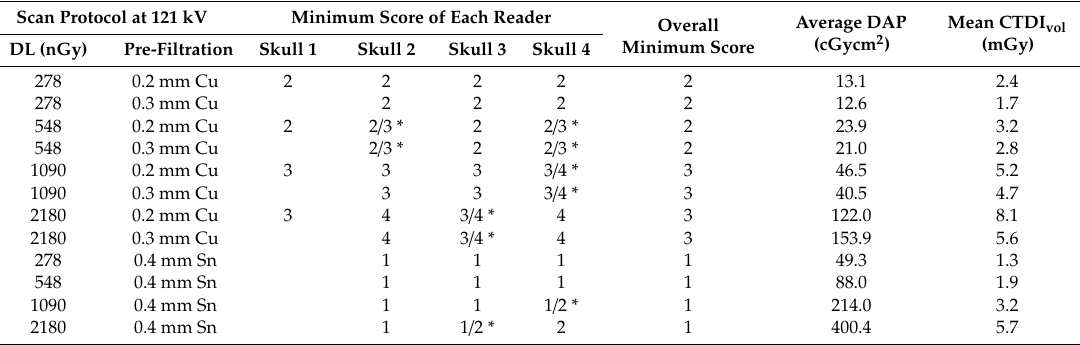
Table 1. Display of the minimum achieved scores of the four skulls depending on the scan protocol (mean value of both readers, stars * mark a di ff erence in the minimum scores of the two readers). Additional information: average radiation exposure values of each protocol (DAP = Dose Area Product, CTDI vol = mean computed tomography volume